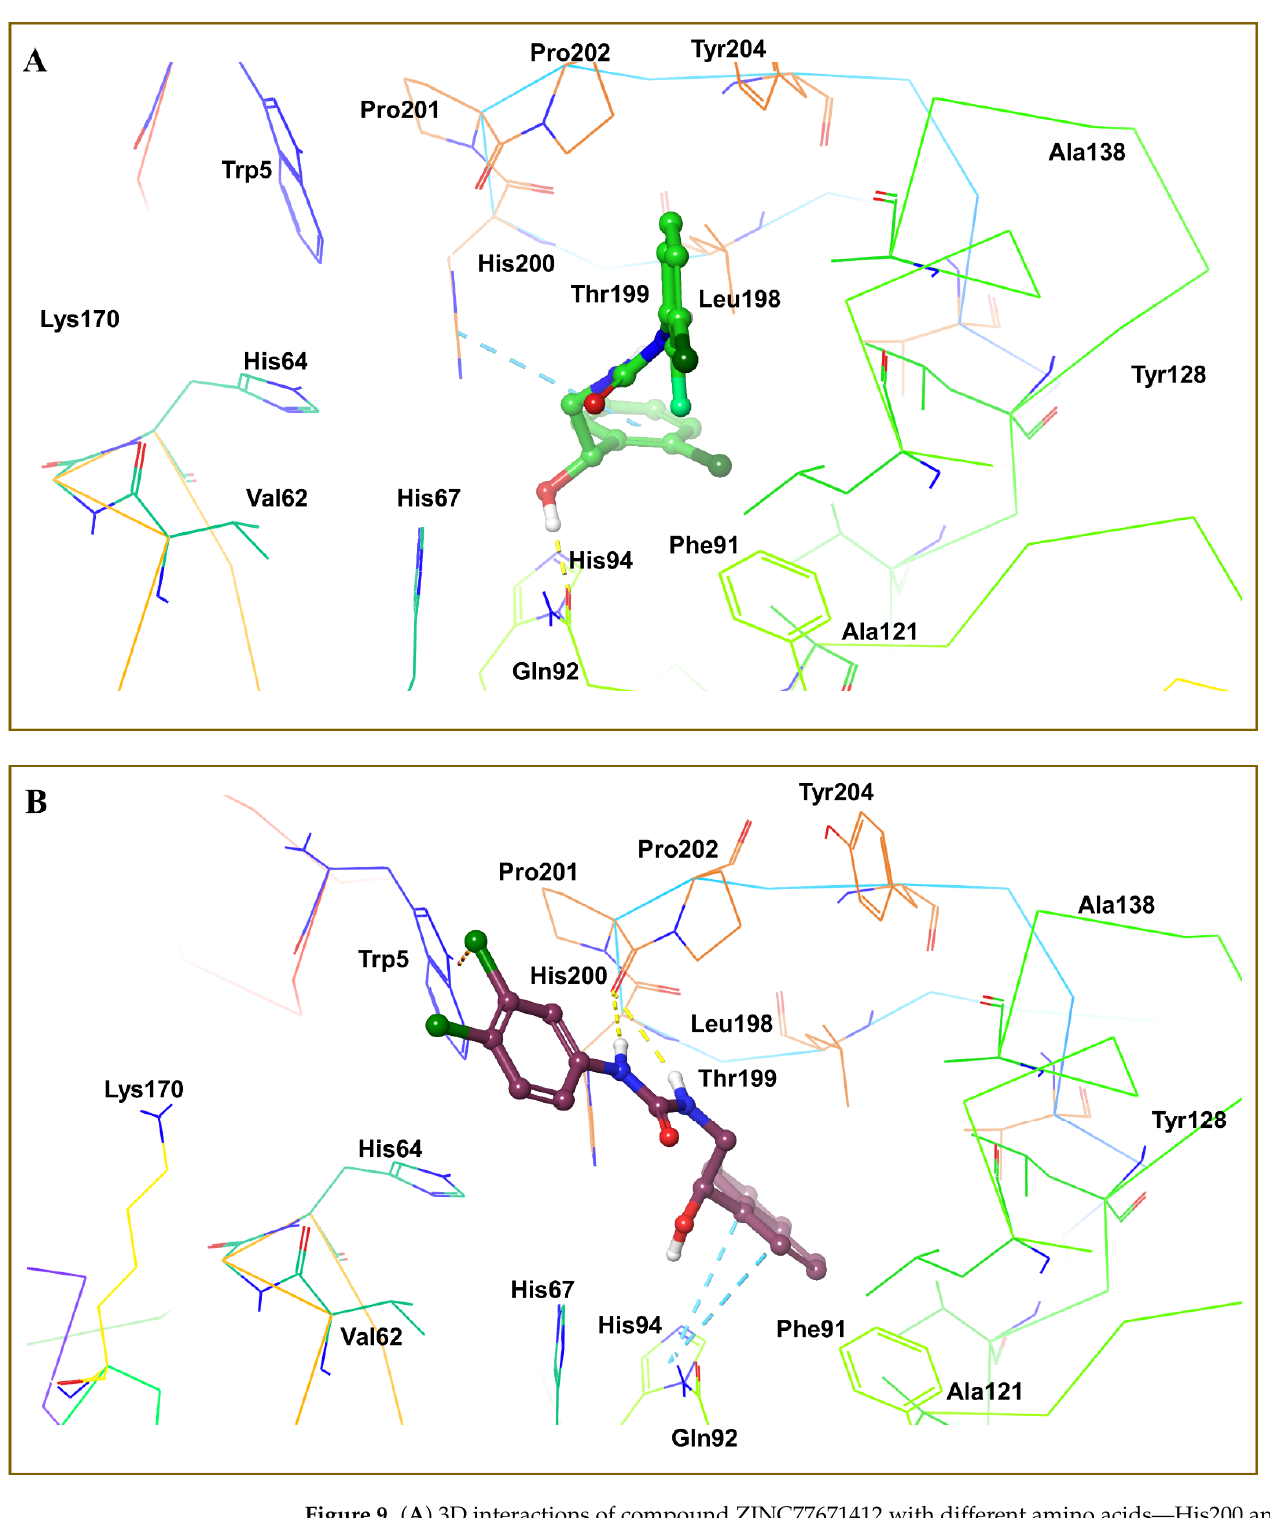
Figure 9. ( A ) 3D interactions of compound ZINC77671412 with different amino acids—His200 and Gln92—at the binding site of receptor 6g3v. ( B ) 3D interactions of compound ZINC70762033 with different amino acids—His200, His94, Gln92, and Thr199—at the binding site of receptor 6g3v.